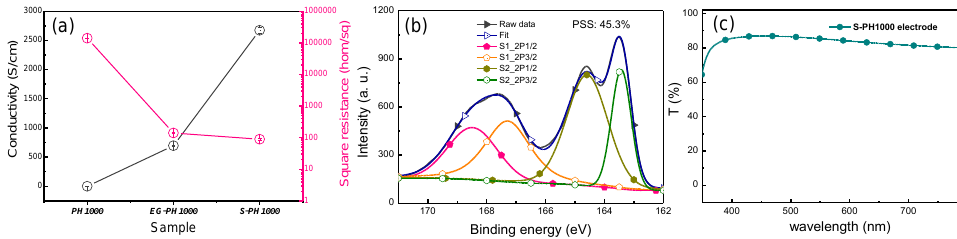
Figure 2. ( a ) Conductivity and square resistance of PH1000, EG-PH1000 and S-PH1000 films. ( b ) XPS spectrum of the S-PH1000 film. ( c ) The transmittance of S-PH1000 electrode.